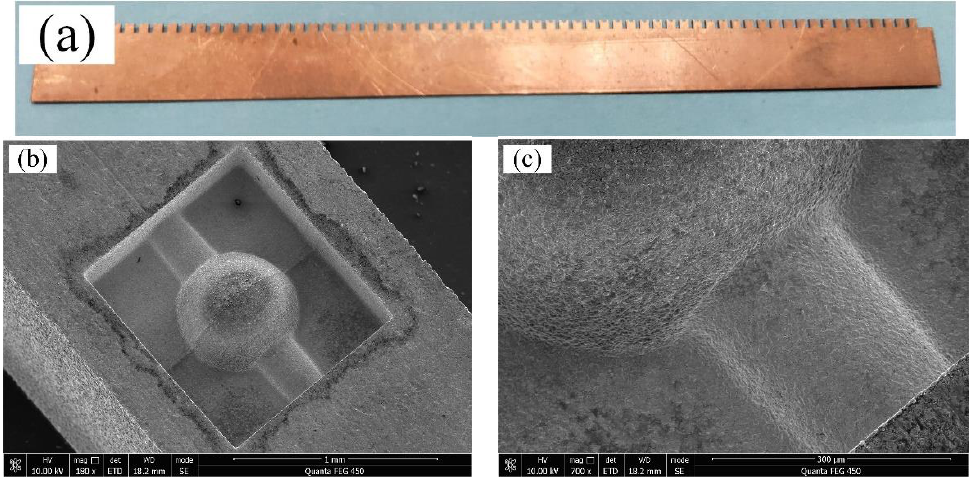
Figure 8. ( a ) FQ-microelectrode with tapered structures; ( b , c ) Micro-EDM results of FQ-microelectrodes observed by scanning electron microscopy.